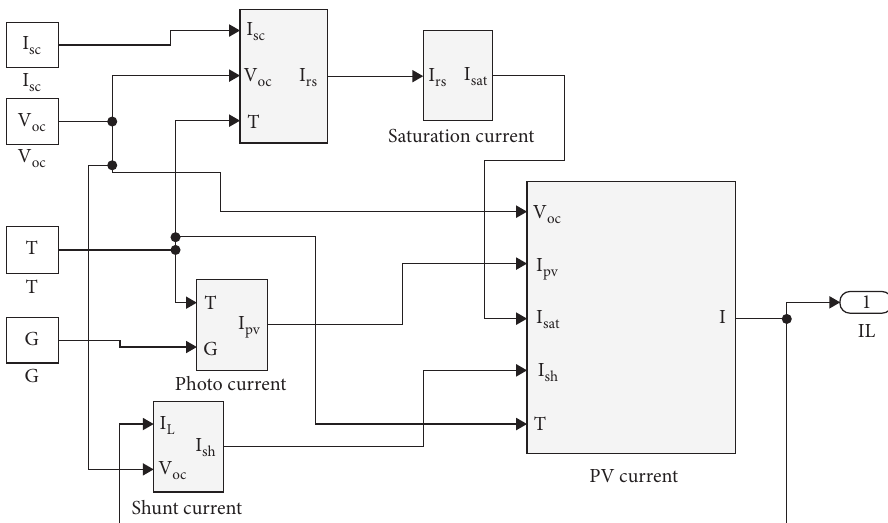
Figure 22: Modelled and implemented PV module node: subsystems